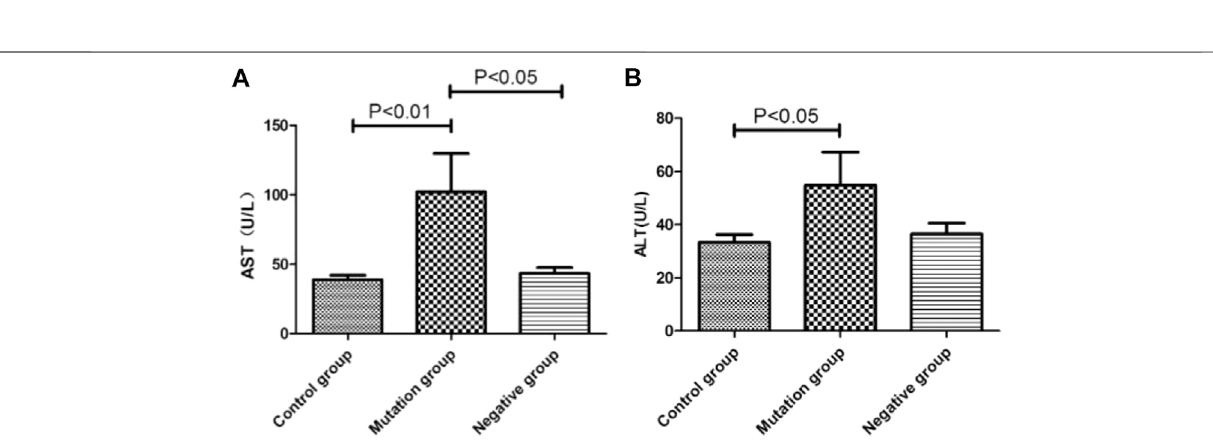
Frontiers in Pharmacology |